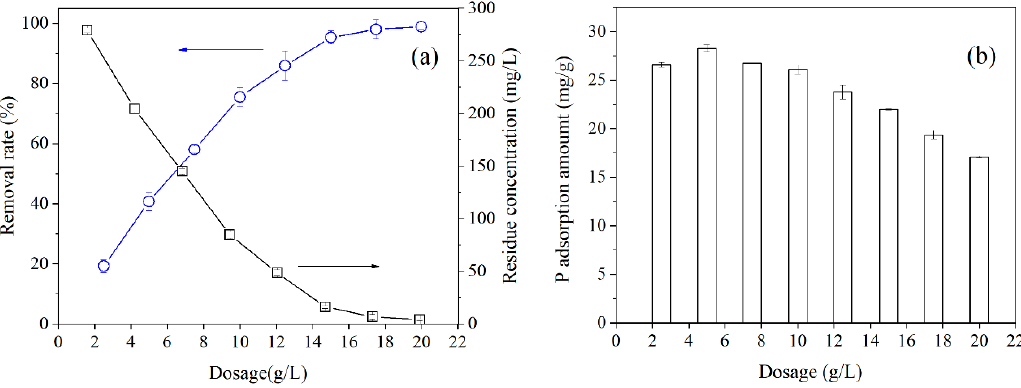
Figure 2. Effect of MZ dosage on phosphate removal rate, residue phosphorus concentration ( a ) and adsorption amount ( b ).